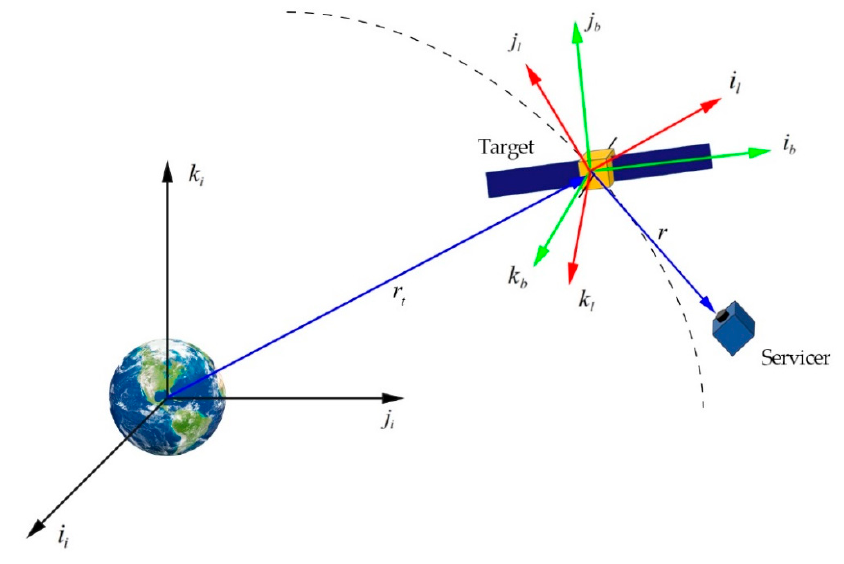
Figure 1. Mission scenario and three different coordinate frames.